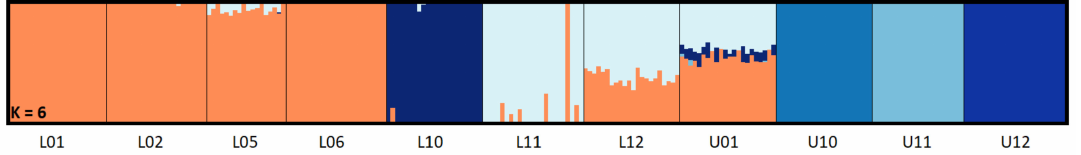
Figure 5. Barplots of population structure with K = 6 clusters in nine-spined stickleback inferred by Bayesian analysis using fastStructure v1.0.